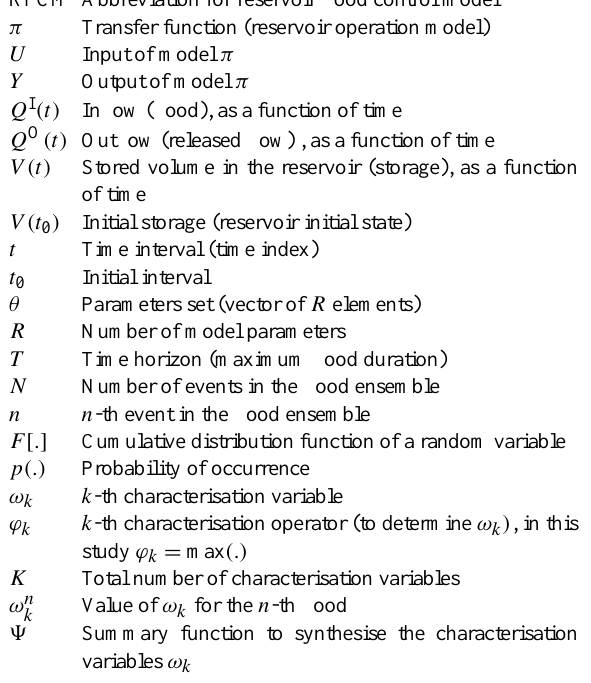
Figure B2 . Example of the storage penalty curve 820